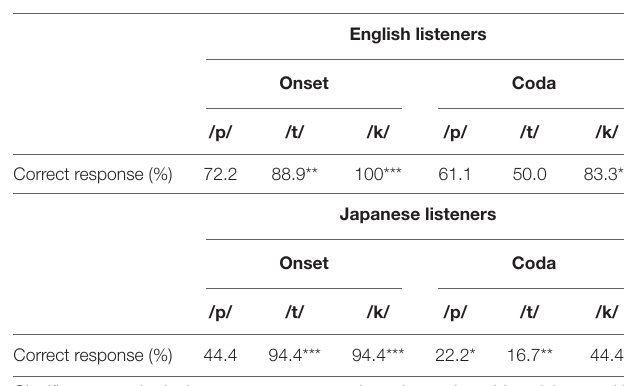
TABLE 4 | Audio-only accuracies for onsets and codas in CVC stimuli, split by correct consonant